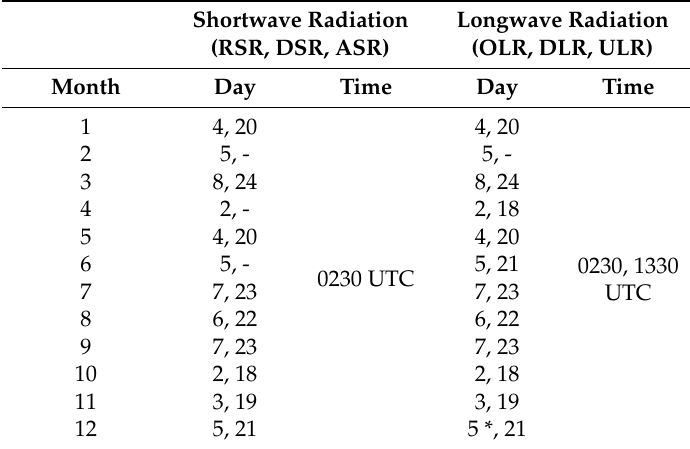
Before Calibration After Calibration